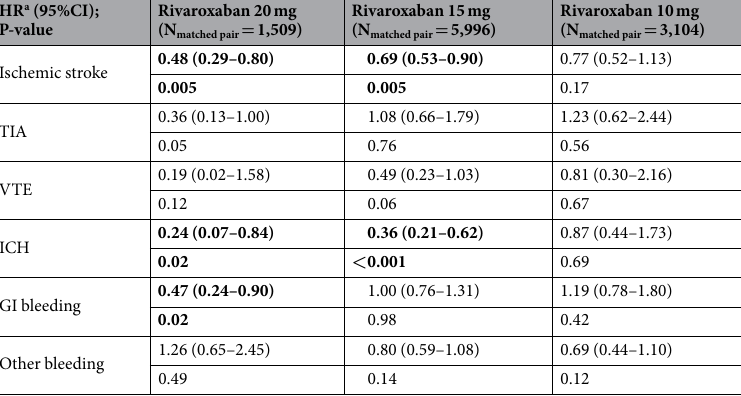
Table 3. Hazard ratios comparing effectiveness and safety outcomes by different rivaroxaban doses prescribed. a Hazard ratios were estimated by the Cox proportional hazard model with the warfarin group serving as a reference. Propensity-score matching hazard ratios were controlled by age, sex, annual stroke risk, history of ischemic stroke/systemic embolism, TIA, VTE, acute myocardial infarction, heart failure, hypertension, renal disease, liver disease, diabetes mellitus, peptic ulcer disease, peripheral vascular disease, ICH, GI bleeding, coagulation deficiency, use of antiplatelet, proton pump inhibitors, histamine-2 receptor antagonist, antacids, non-steroid anti-inflammatory drugs, antiarrhythmic drugs, digoxin, beta-blockers, calcium channel blockers, angiotensin converting enzyme inhibitors/angiotensin receptor II blockers, statins, and anti-diabetes